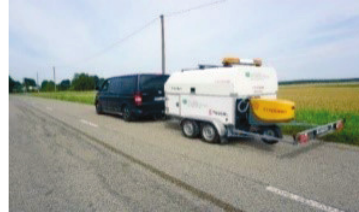
Figure 3. Road Analyser and Recorder of ViaTech